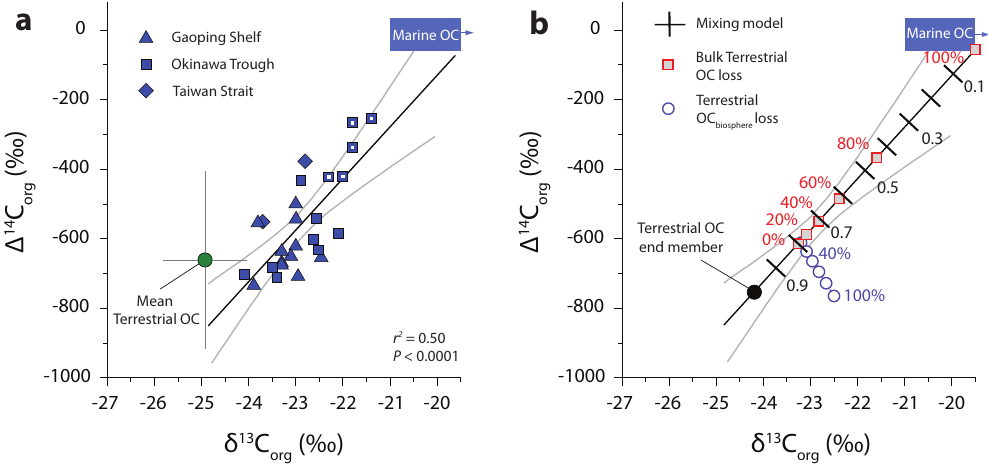
Figure 4. Stable and radioactive isotopic compositions of organic carbon ( δ 13 C org and ∆ 14 C org , ‰) in marine sediments o ff shore Taiwan fed by dispersive terrestrial inputs (Fig. 1). (a) White dots denote samples from the trap moorings. The mean terrestrial OC composition delivered by rivers (green circle, whiskers ± SD) and the expected composition of recent marine OC (blue box) are shown. The samples display a positive linear relationship (black line, with 95% confidence intervals in grey). (b) Linear relationship displayed in the samples along with the isotopic composition of OC predicted by (i) mixing marine OC and terrestrial OC (black line and dashes with fraction of terrestrial OC); (ii) loss of terrestrial OC biosphere starting at fraction terrestrial OC = 0.8 (circles with % loss); and (iii) bulk terrestrial OC loss (squares with % loss).